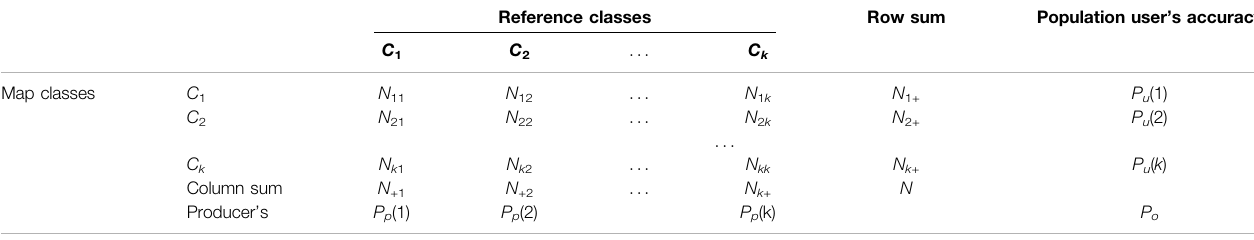
TABLE 1 | Population confusion matrix for k -class land-use/land-cover classi fi cation using classi fi cation rules established by a training data set.